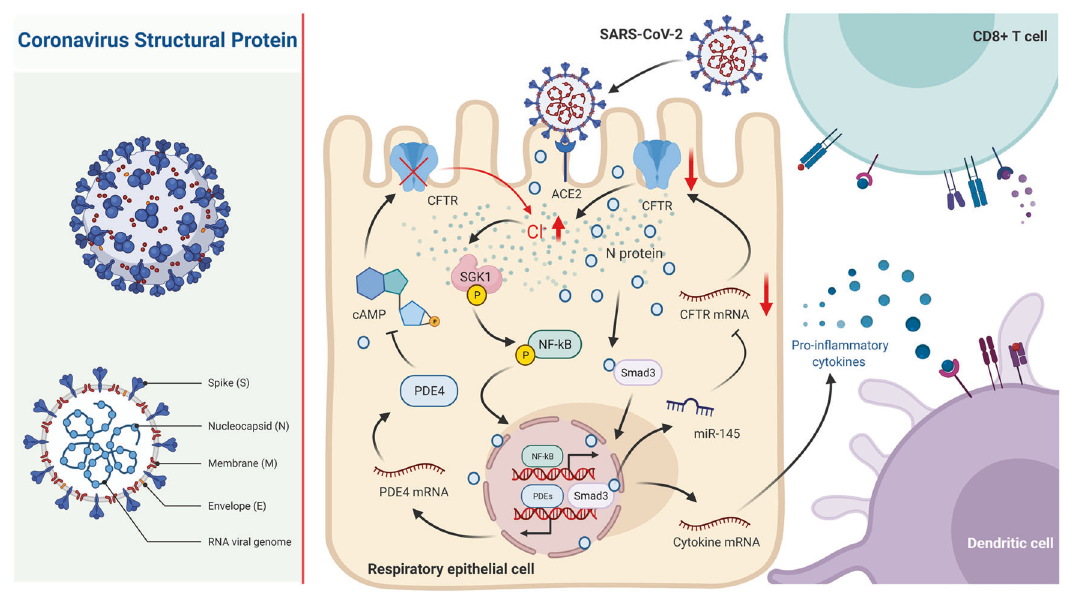
Fig. 8 Schematic diagram depicting the role of intracellular Cl − accumulation in eliciting an ongoing in fl ammatory response after SARS-CoV-2 N protein stimulation in RECs. In RECs, the N protein interacted with Smad3, which triggered the downregulation of the CFTR via miR-145. Thereafter, the [Cl − ] i was elevated and elicited in fl ammatory responses through activating the Cl − -sensing SGK1. Moreover, the expression of PDE4 was upregulated owing to the activation of NF- κ B, which resulted in cAMP degradation and dysfunction of CFTR, contributing to the sustained high [Cl − ] i and ongoing airway in fl ammation. [Created with BioRender.com